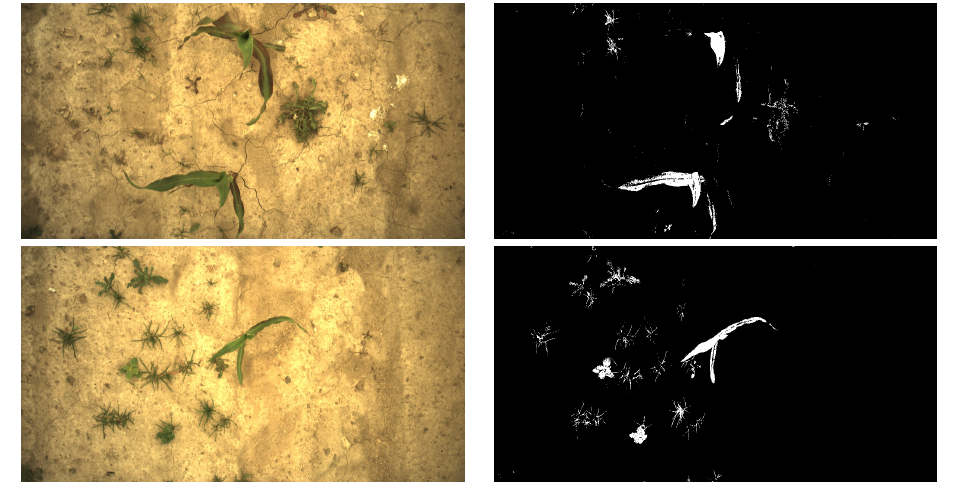
Figure A1. Segmentation examples.